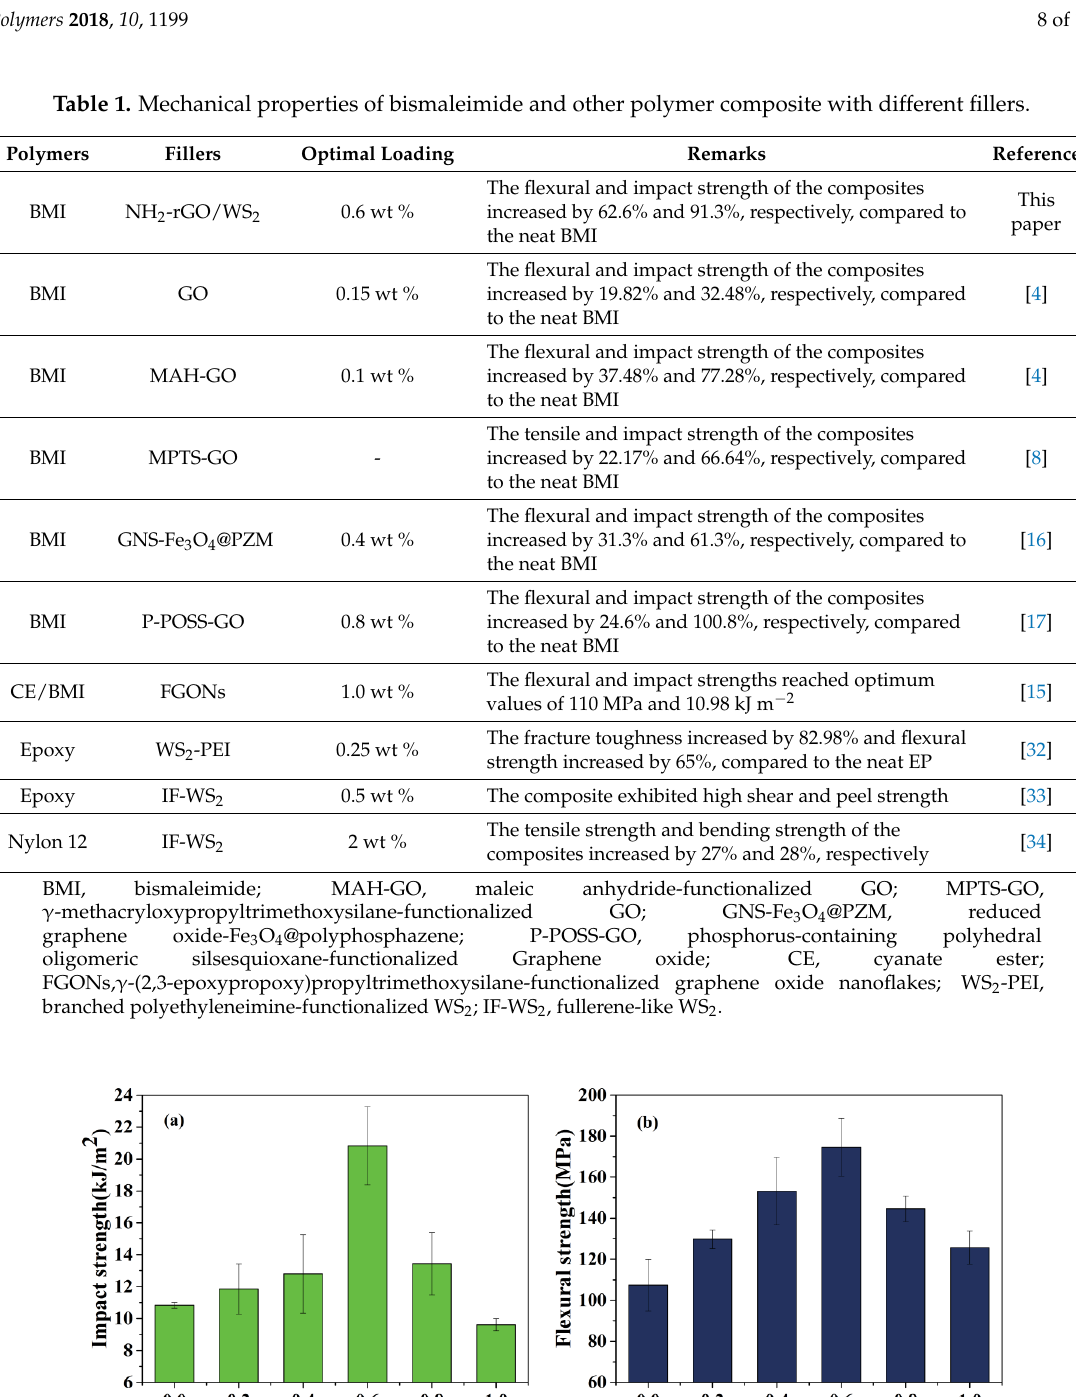
Table 1. Mechanical properties of bismaleimide and other polymer composite with different fillers. Polymers